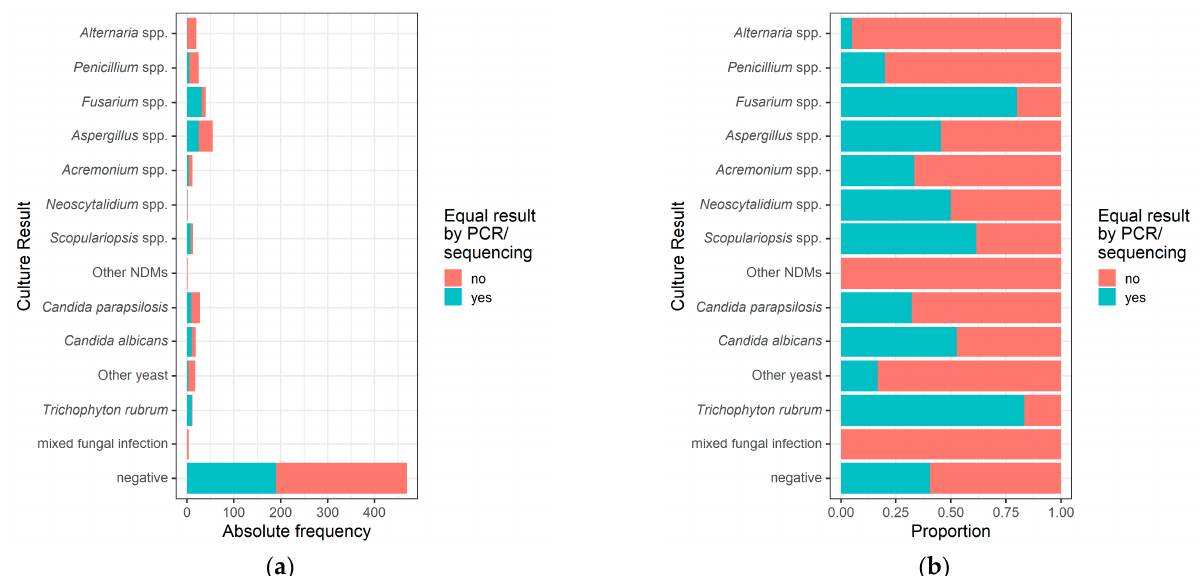
Figure 2. Comparison of the culture with the corresponding PCR/sequencing results in absolute ( a ) and relative ( b ) numbers. Agreement of culture with the subsequent PCR/sequencing results differed among the culturally identified fungi.